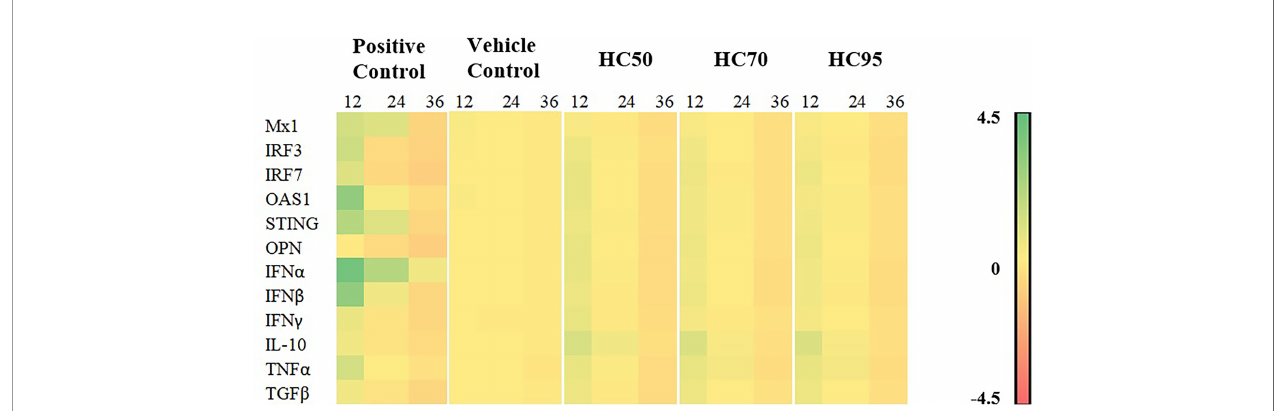
FIGURE 3 | Heat map illustrating levels of immune-related gene expressions of MDMs ( n = 4 pigs) treated with HC50, HC70, and HC95 (0.8 mg/ml fi nal) for 12, 24, and 36 h as determined by real-time PCR. MDMs stimulated with poly IC (for induction of Mx1 , IRF3 , IRF7 , OAS1 , STING , OPN , IFN a , IFN b , IL-10 , and TGF b gene expressions) or LPS (for induction of IFN g and TNF a gene expressions) served as positive control. mRNA expressions of immune-related genes were normalized to geometric average of two housekeeping genes, i.e., RPL32 and YWHAZ , of the same pigs. Expressions of immune-related genes in all groups were transformed to log2 scale and were presented in fold change, according to the 2 − DD CT method, relative to those in untreated control.